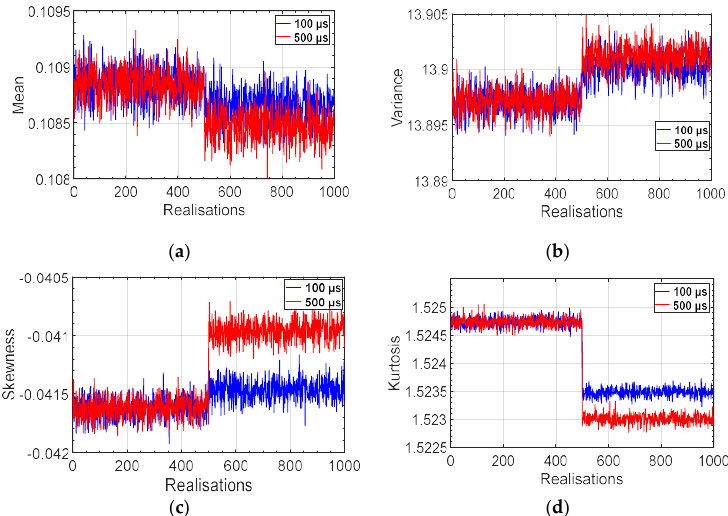
Figure 7. Statistical moments for two OSF durations with SNR = 40 dB: ( a ) With mean value, ( b ) With